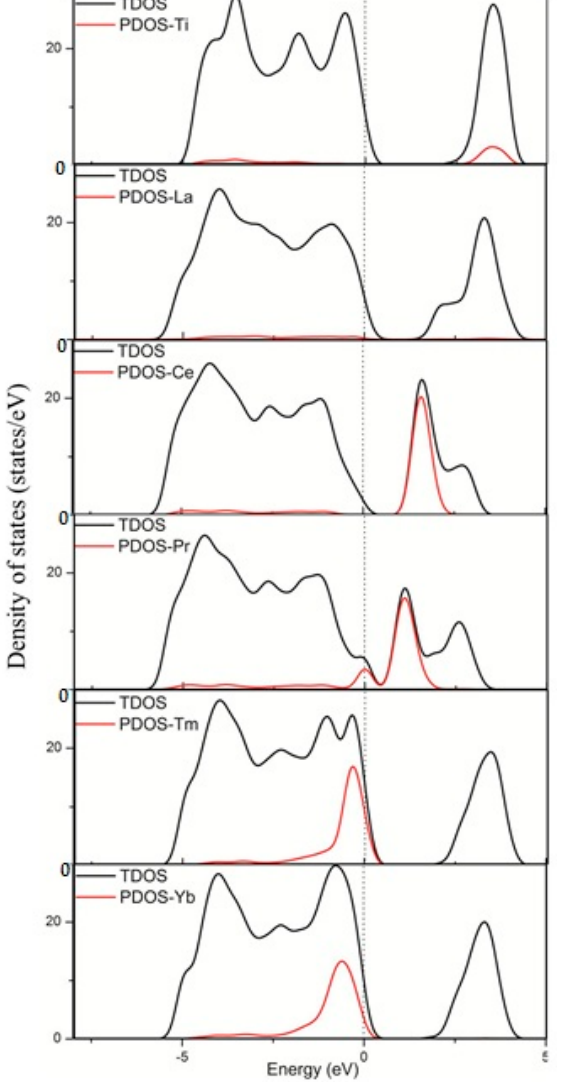
Figure 2. Calculated total DOS and PDOS of the pure TiO 2 and TiO 2 doped by La, Ce, Pr, Tm, and Yb. The Fermi levels are set at the zero of energy.